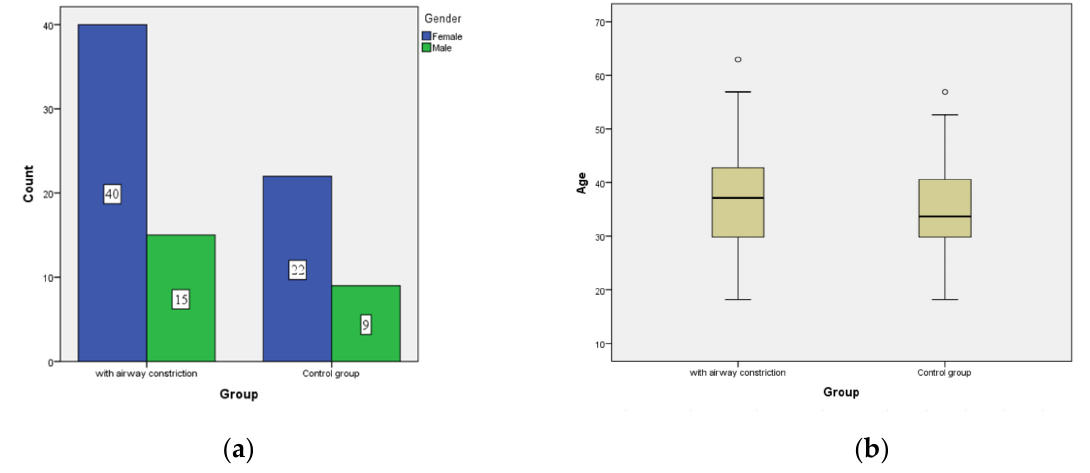
Figure 5. Sex and age distribution between groups. ( a ) The groups did not differ statistically significantly in the proportion of women and men. ( b ) The groups did not differ statistically significantly in the proportion of women and men.